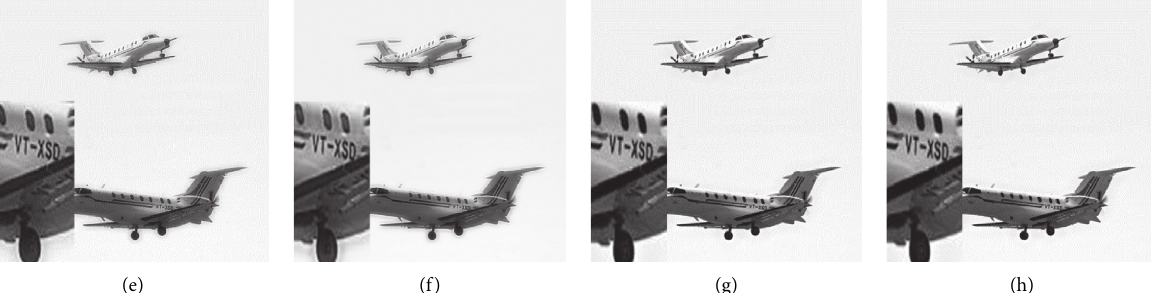
Figure 7: The fusion results of “Plane.” (a) PCNN. (b) Contourlet. (c) GAN. (d) Shearlet. (e) CSR. (f) SR-SML. (g) DCNN. (h) Proposed.